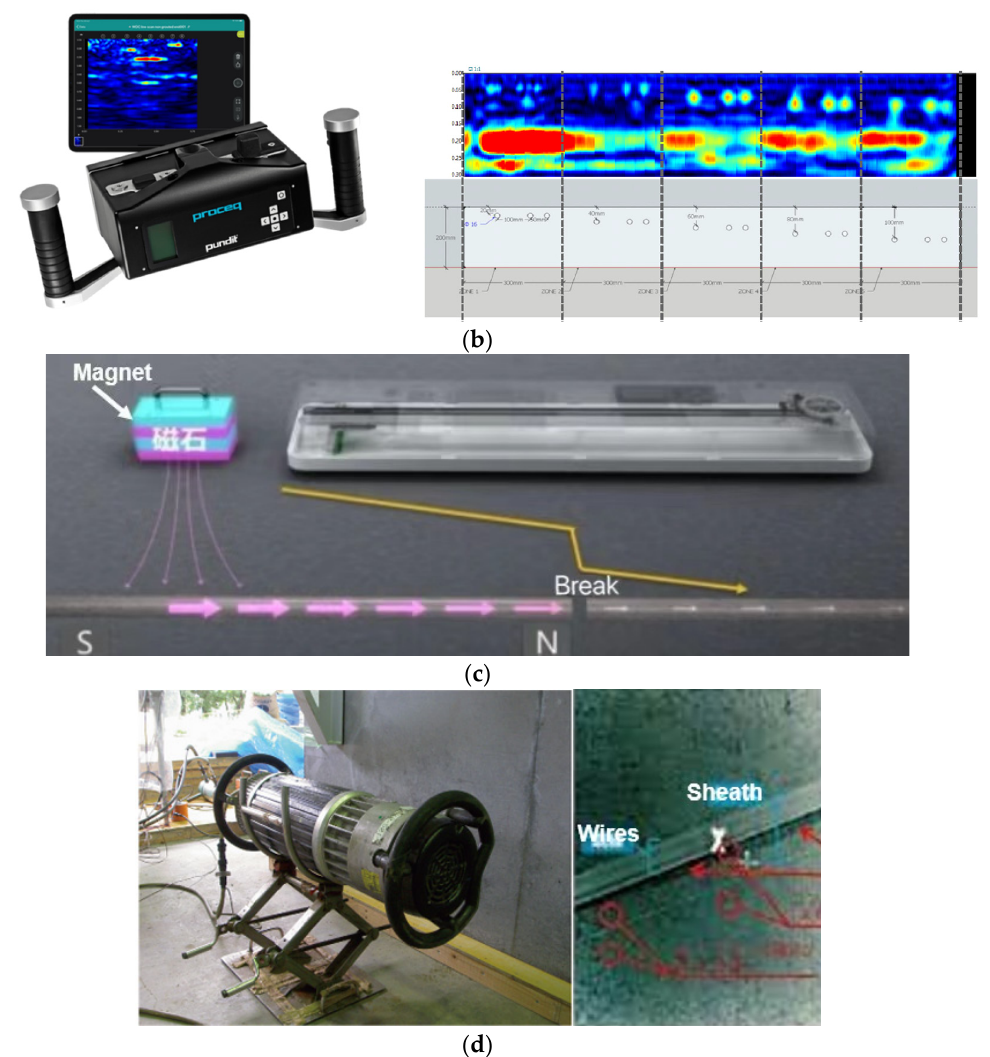
Figure 8. Other inspection methods for the inner structure of bridges. ( a ) RADAR (1.6–3 GHz) [10]; ( b ) ultrasonic testing (50 kHz) [11]; ( c ) magnetic testing [12]; ( d ) X-ray tubes (200–400 keV) [13].